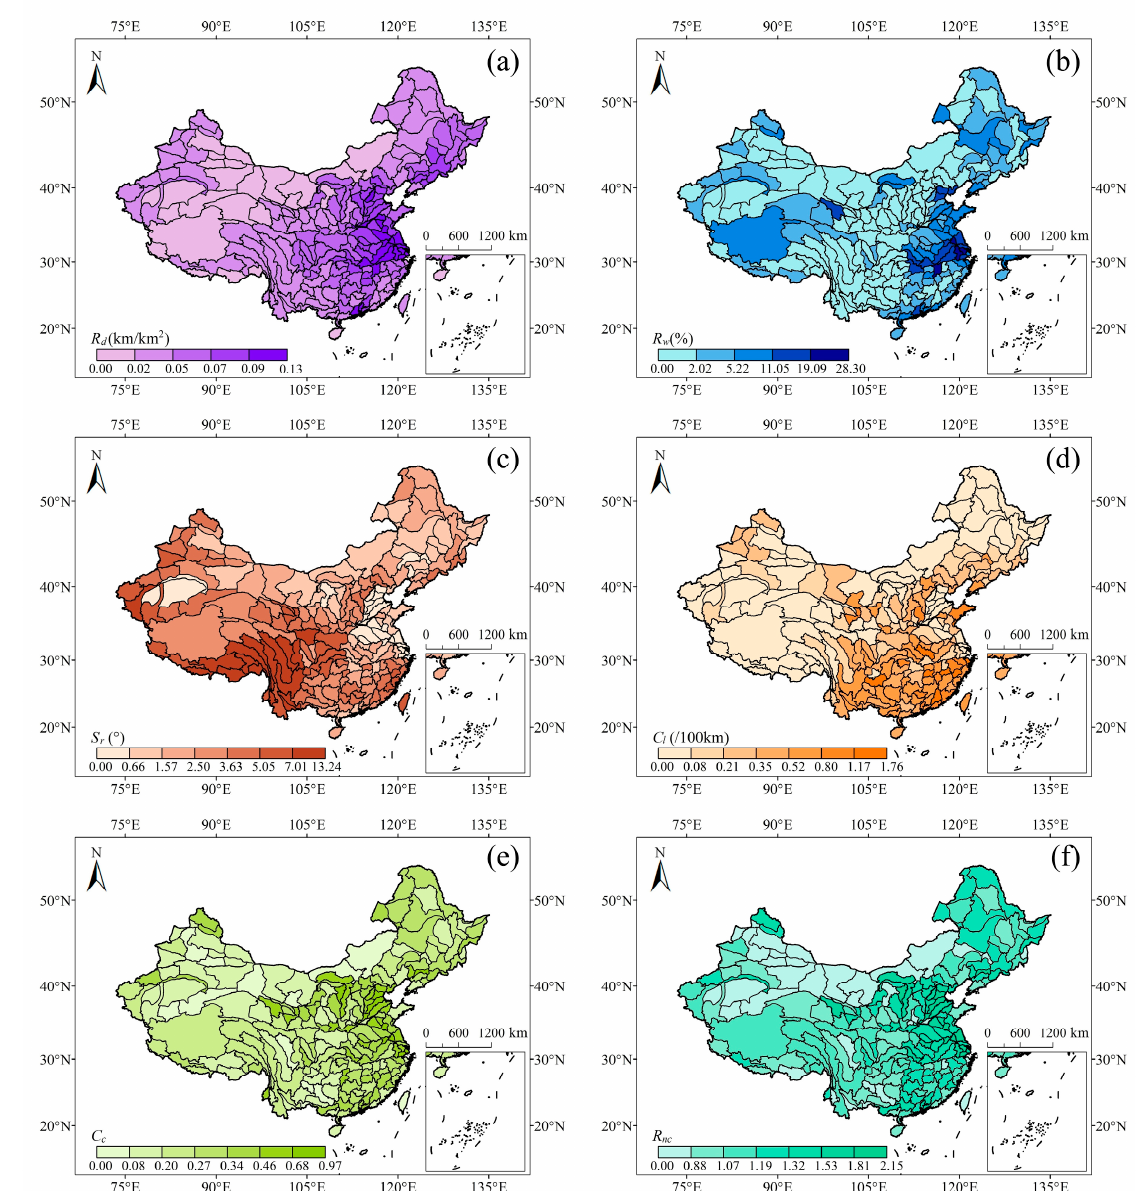
Figure 4. Maps of the spatial distributions of ( a ) river density ( R d ), ( b ) water surface ratio ( R w ), ( c ) average slope ( S r ), ( d ) longitudinal connectivity ( C l ), ( e ) cyclical connectivity ( C c ) and ( f ) node connection ratio ( R nc ) in China.